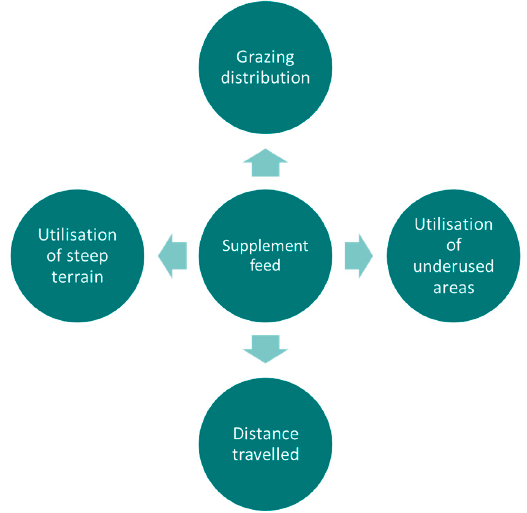
Figure 10. Summary diagram of the main variables of site use preference being affected by the location and number of supplemental feed points.